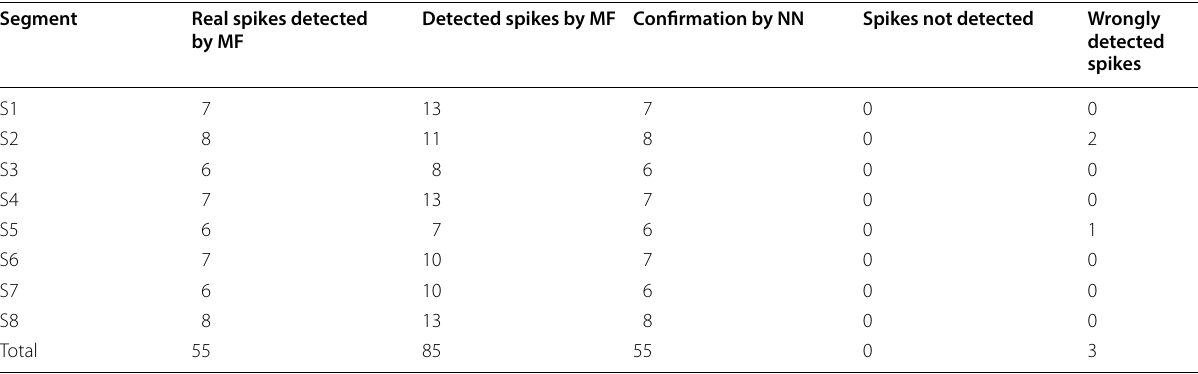
Table 5 Results of reviewing detected spikes by the neural network Segment Real spikes detected by MF